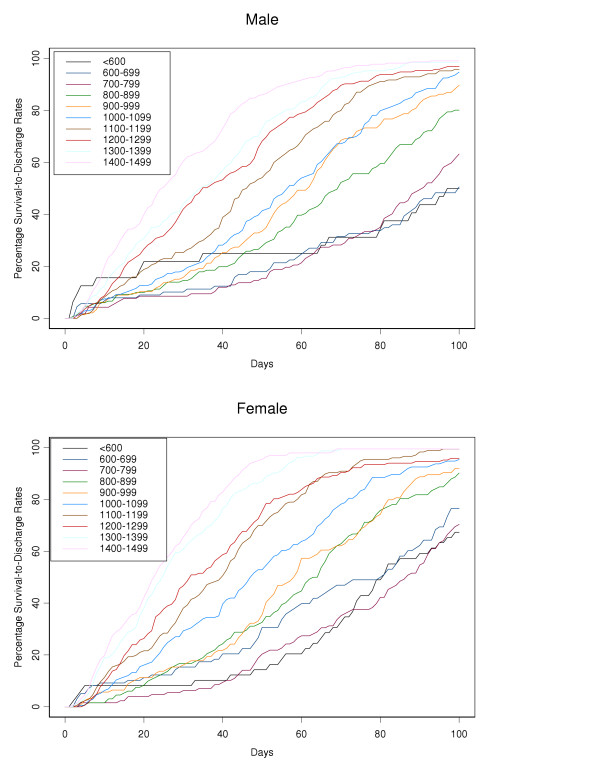
Probability of survival to discharge (y-axis), for male and female infants surviving to a given day in the NICU (x-axis), stratified by birth weight (g).